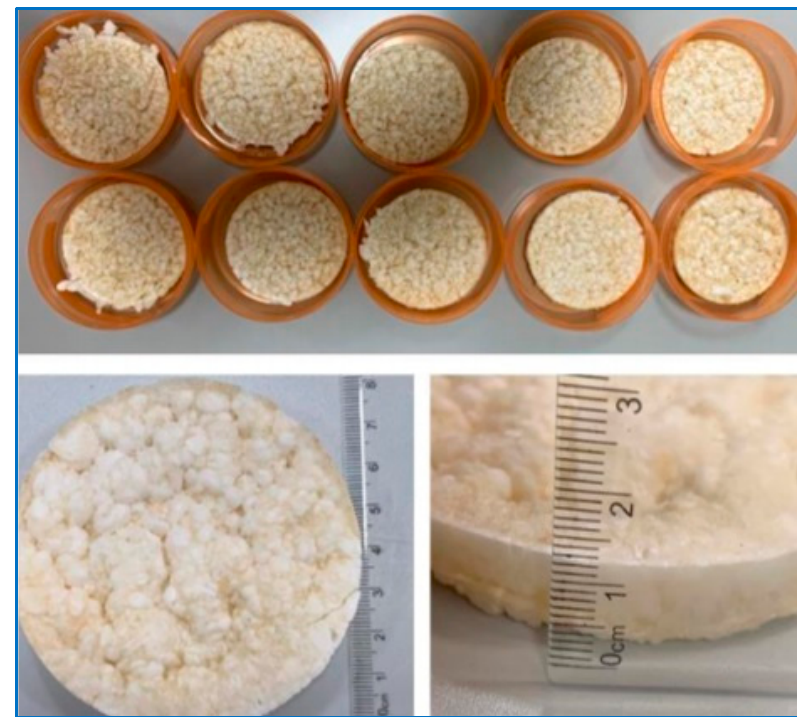
Figure 2. Final produced samples size, shape, and thickness.